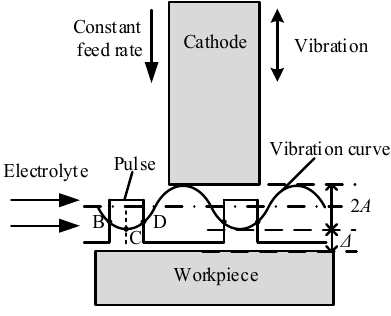
Figure 1. Traditional symmetry coupling mode of pulse duration and tool vibration.